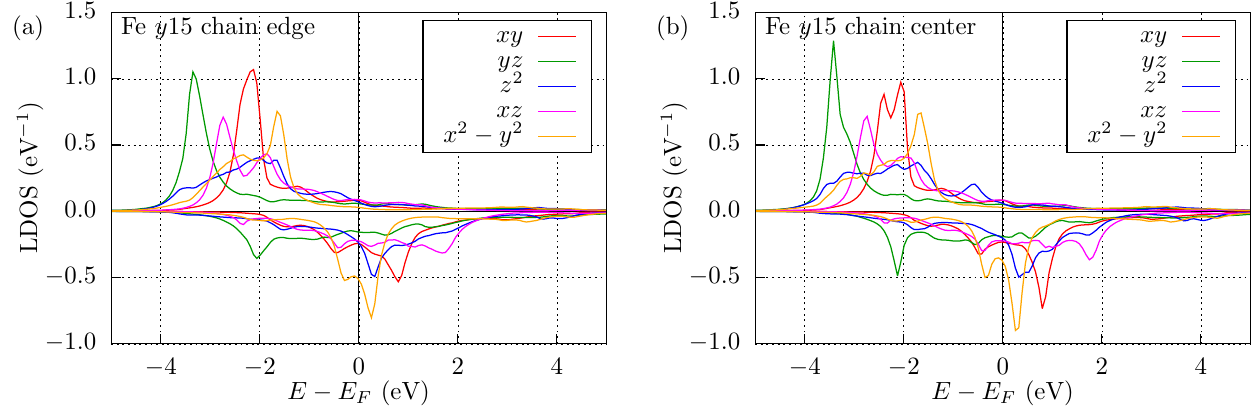
Figure 4. Local density of states of the Fe y 15 chain. Spin-resolved LDOS of ( a ) the edge and ( b ) the center atom. Positive and negative values correspond to majority and minority spin channels, respectively. The Fermi energy is denoted by a vertical black line at E =